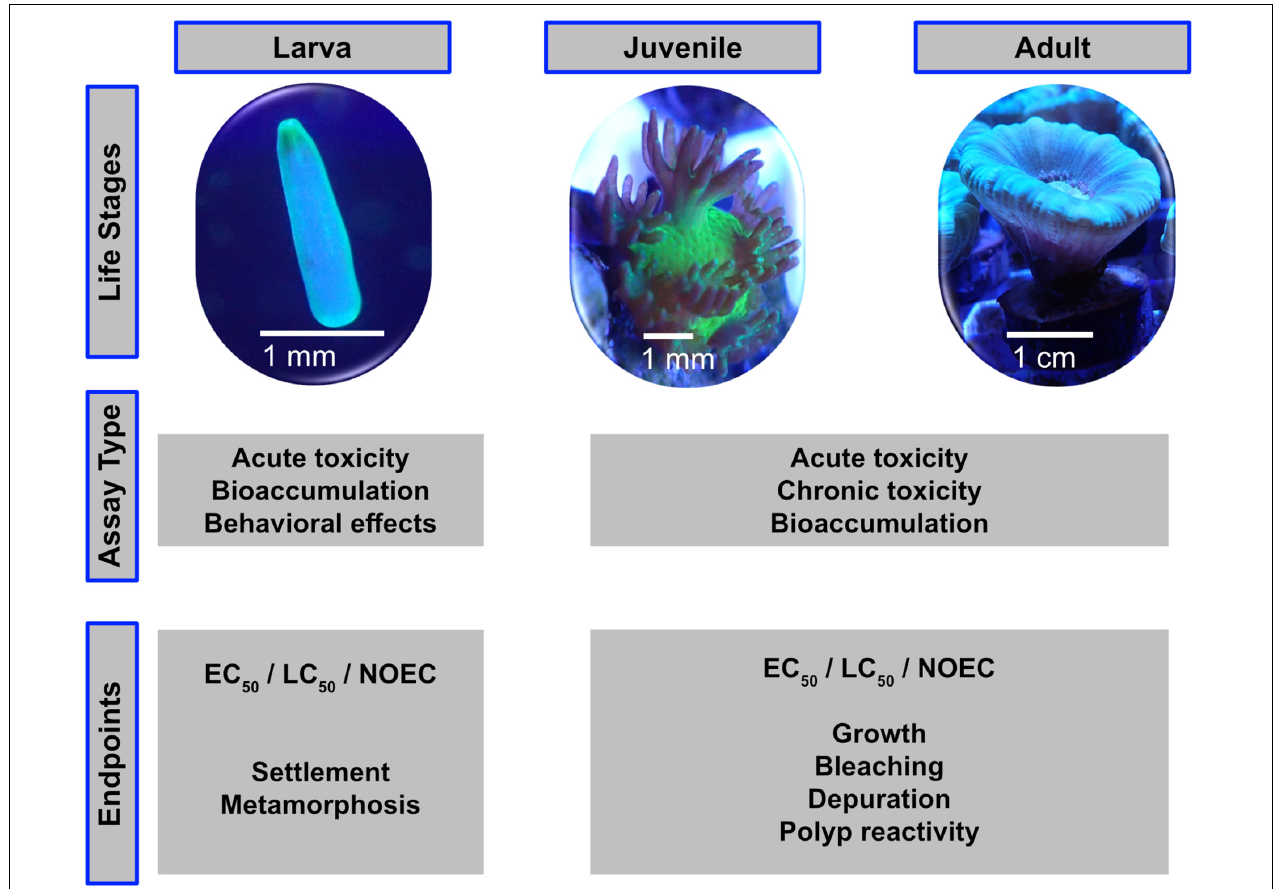
FIGURE 1 | The life stages of scleractinian corals are suitable for different assay types and toxicity